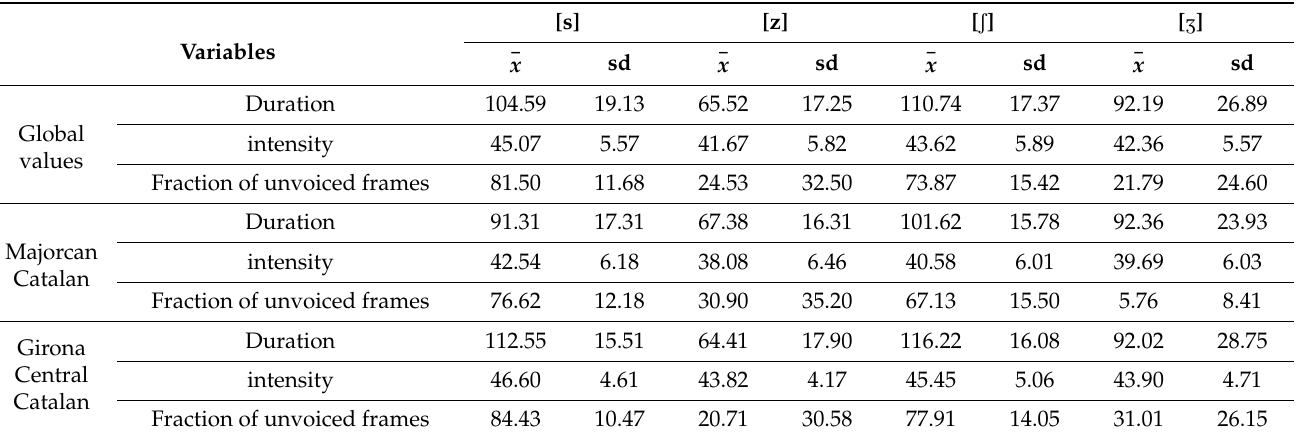
Table 4. Mean value and standard deviation for the dependent variables. Duration values are offered in milliseconds, intensity in decibels, and the fraction of unvoiced frames is presented as a percentage of the sound’s